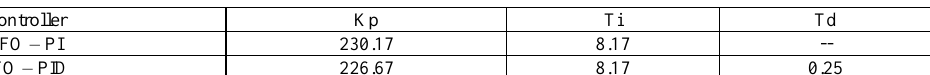
Table 4. EFO tuning values